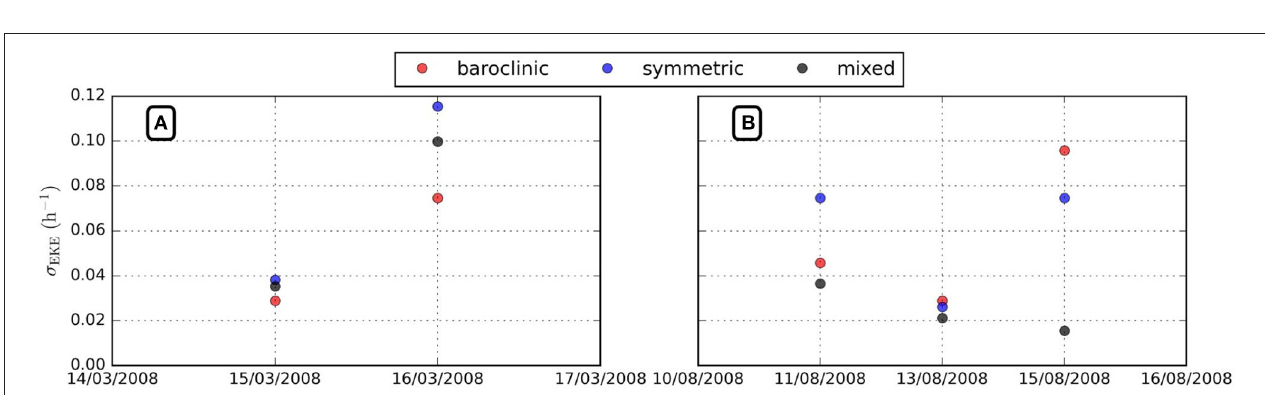
FIGURE 12 | Decomposition of the EKE and the EAPE onto individual modes of instability : symmetric mode (blue color) in March (A) and in August (D) , baroclinic mode (red color) in March (B) and in August (E) and mixed mode (black color) in March (C) and in August (F) . The solid lines characterize the EKE decomposition and dashed lines indicate the EAPE decomposition.